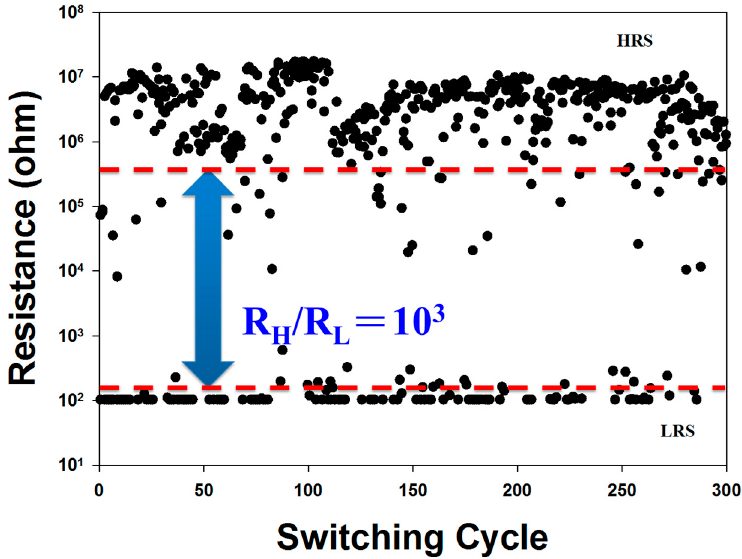
Figure 8. Endurance characteristics of the SCF-treated thin films RRAM devices at room temperature as measured at 0.5 V.